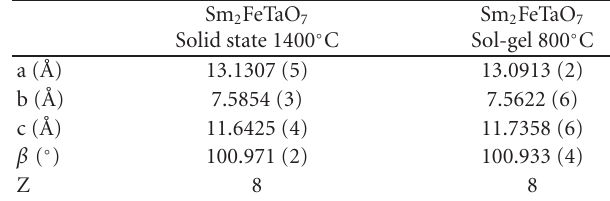
Table 1: Cell parameters for Sm 2 FeTaO 7 [17].